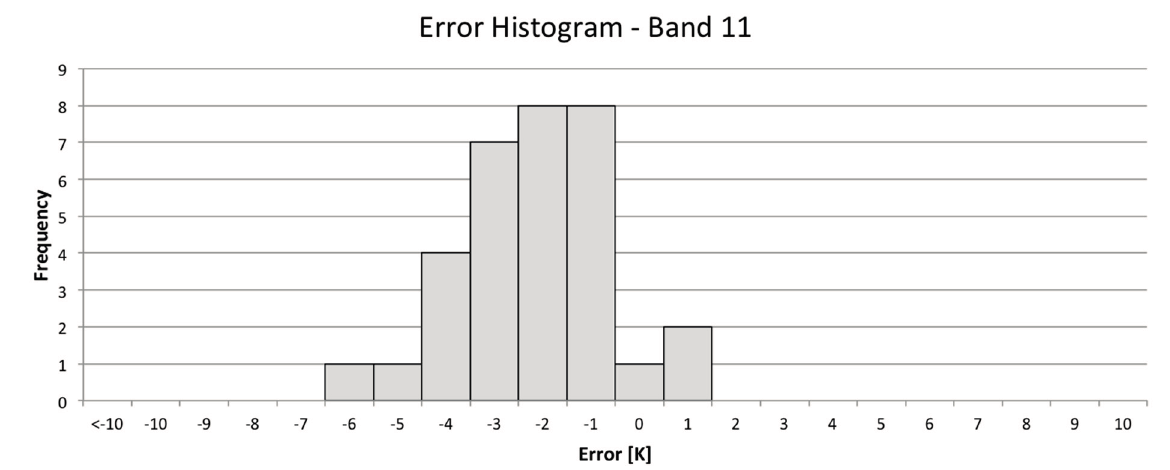
Figure 15. Histogram of errors for Landsat 8 band 11 including only cloud free scenes.